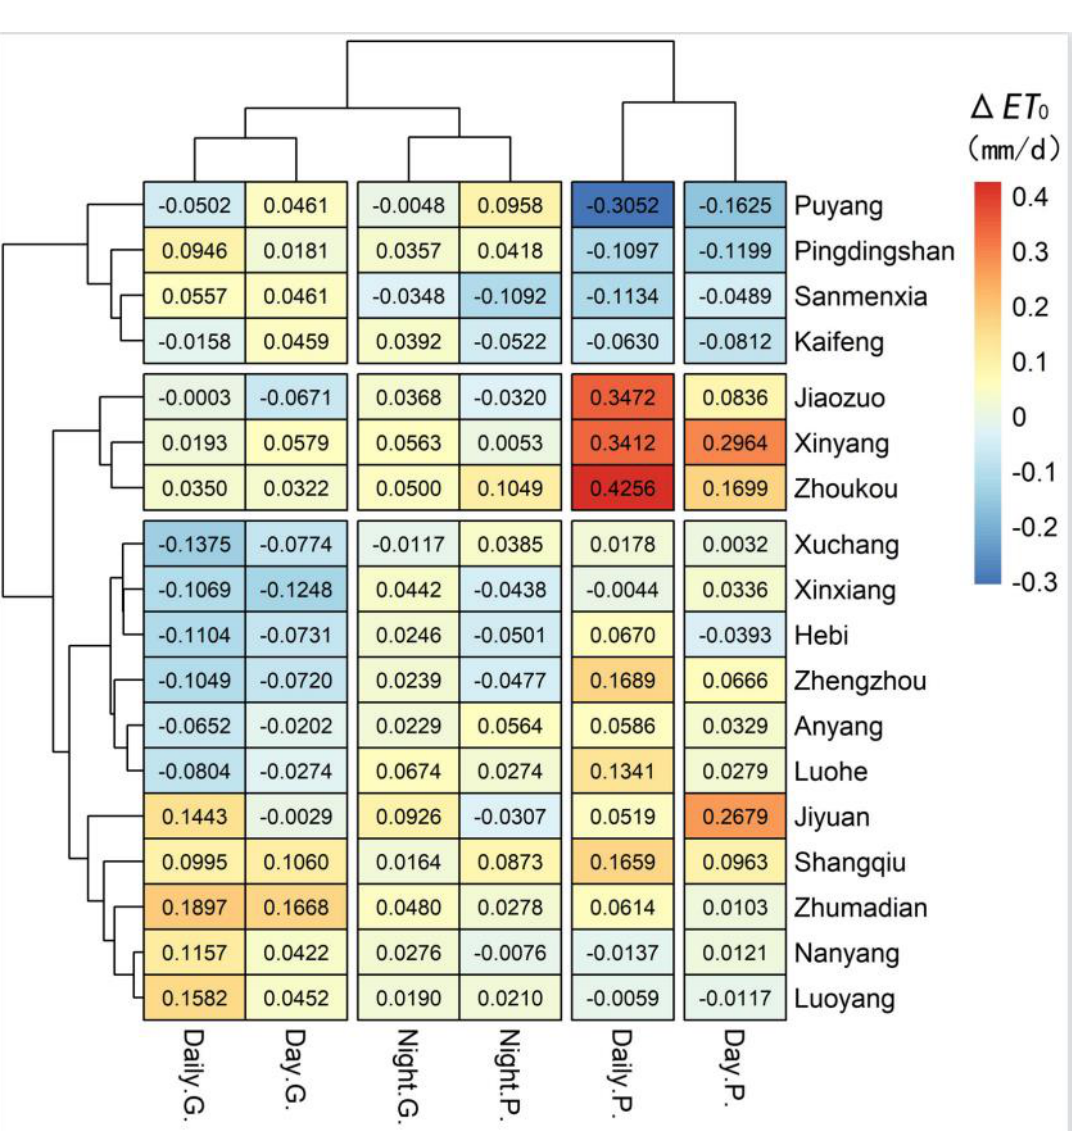
Figure 6. Effect of aerosols on ET 0 at daily and day-night scales under different pollution conditions in various cities.